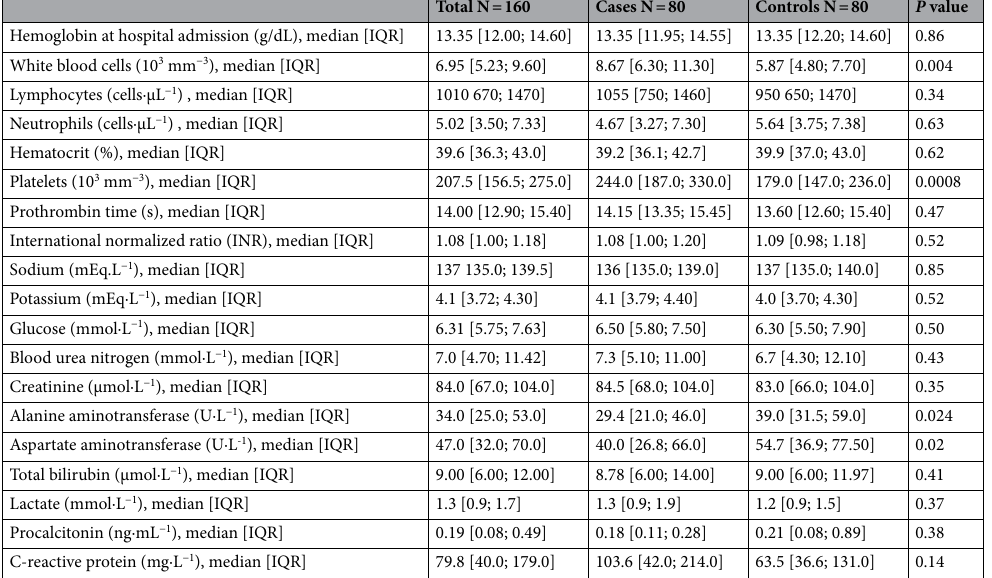
Table 2. Laboratory test results in the study population. IQR interquartile range.